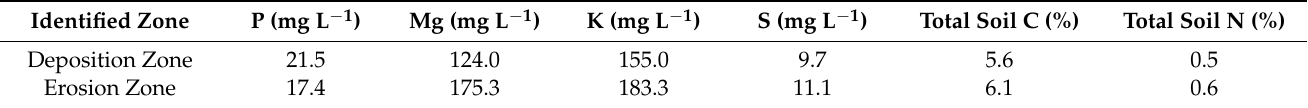
Table 1. Average Soil Nutrient Content (mg L − 1 ) for P, Mg, K, and S, Total Soil C (%) and Total Soil N (%) of corresponding 35 m gridded soil sampling points for identified deposition and erosion zones.